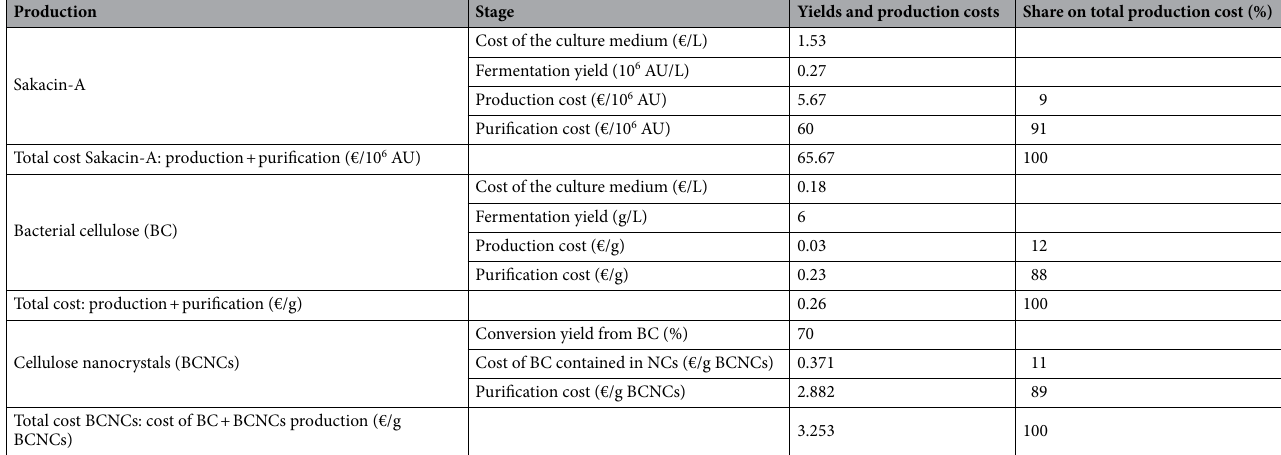
Table 3. yields and production costs for Sakacin A, bacterial cellulose (BC) and cellulose nanocrystals